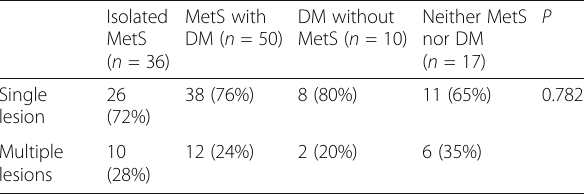
Table 3 Brain imaging in studied